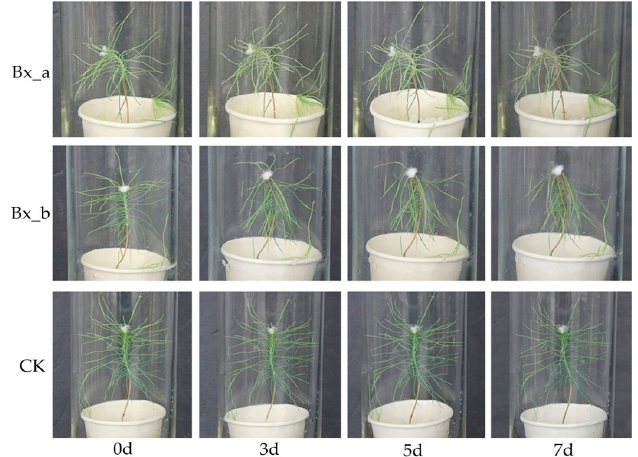
Figure 1. Disease phenotype of pine seedlings inoculated with aseptic B. xylophilus (Bx_a), B. xylophilus with S. maltophilia (Bx_b), or S. maltophilia alone (CK), at 0, 3, 5, and 7 days post inoculation (dpi), respectively. Table 1. The degree of pine wilt disease after P. massoniana seedlings were inoculated with aseptic B. xylophilus (Bx_a), B. xylophilus with S. maltophilia (Bx_b), or S. maltophilia alone (CK), at 3, 5, and 7 days post inoculation (dpi), respectively.